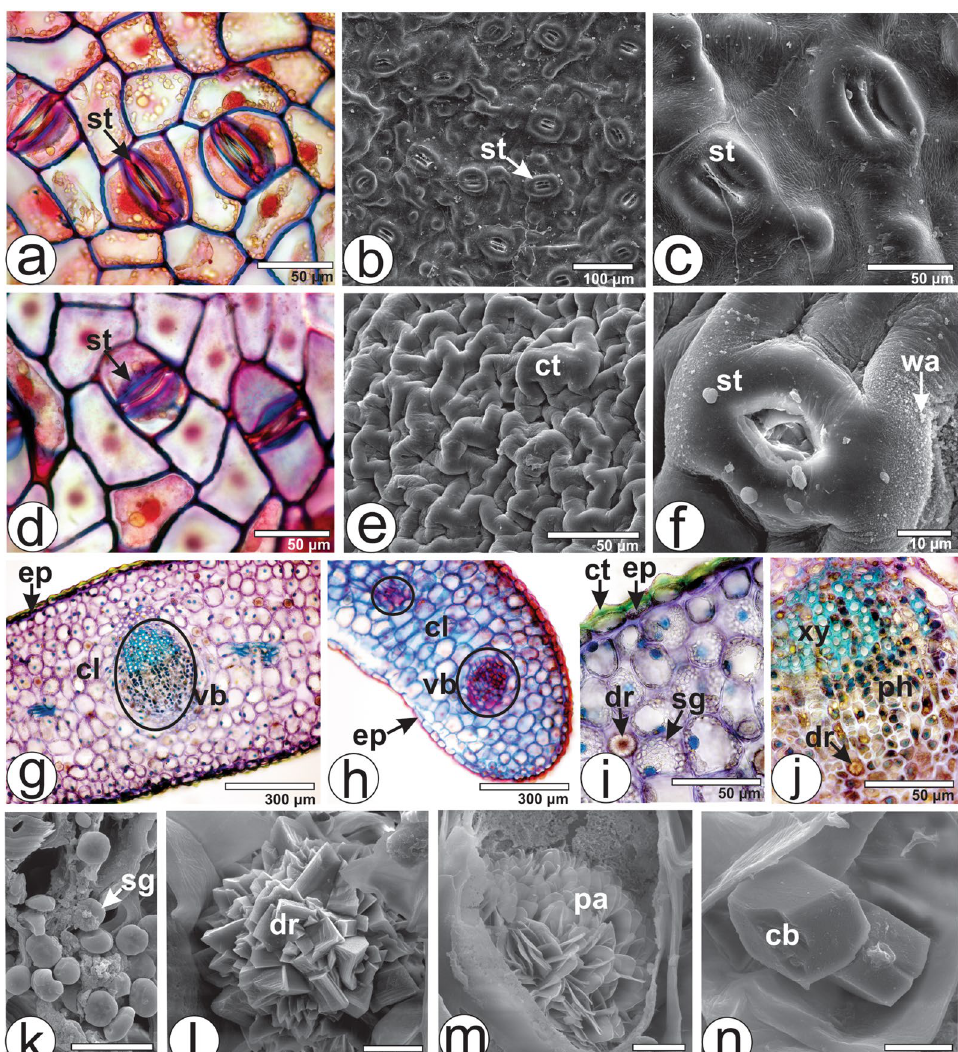
Figure 2. Anatomy of the leaves of Viscum album subsp. album : ( a , d , g–j ) light microscopy and ( b , c , e , f , k – n ) SEM. ( a – c ) Adaxial and ( d – f ) abaxial sides on the leaf. ( a – f ) Leaf in surface view. ( g – n ) Transverse sections.